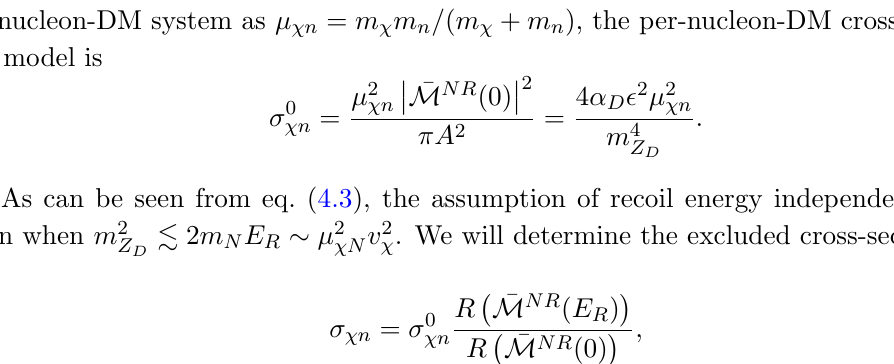
Figure 8. Direct detection at XENON 1T, DarkSide-50 and CRESST constrain the portal coupling (cid:15) to be smaller than the values shown by the contours in the plane of r = m Z r (cid:28) 1, the constraints force the model below the equilibration (cid:13)oor. In red, we show where the model is required to be at or below the late leak-in dark matter scenario. In green, the model is required to be in reannihilation or below, while the narrow purple sliver is in early leak-in. See (cid:12)gure 4 for more